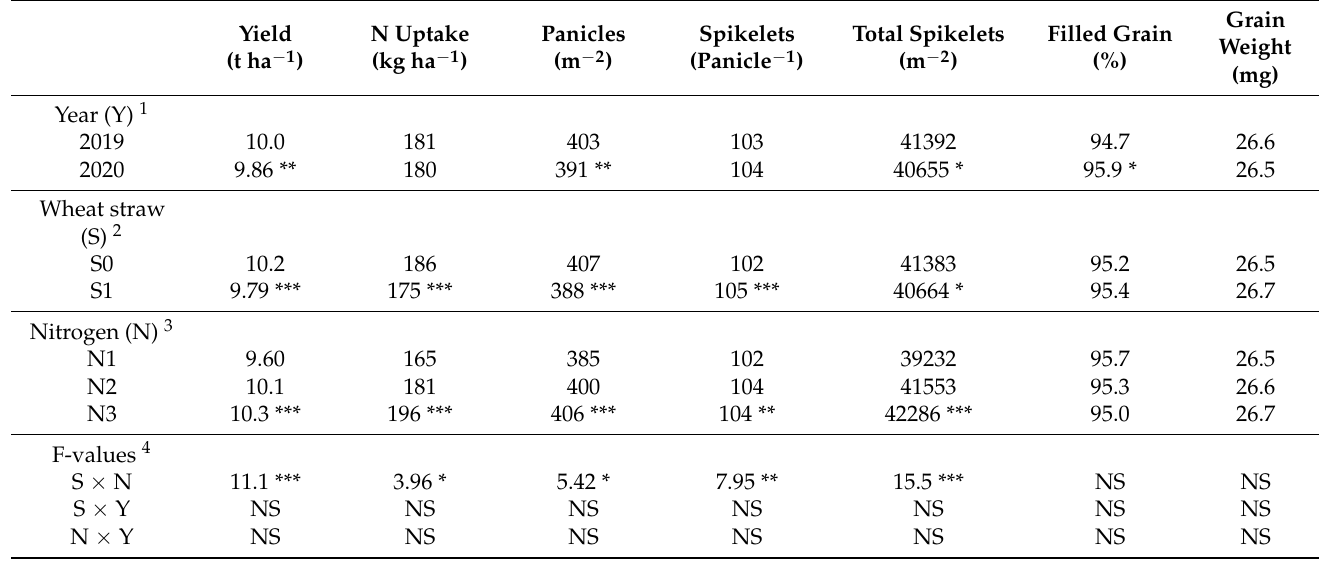
Table 2. Average yield, N uptake, and yield components at maturity as affected by wheat straw